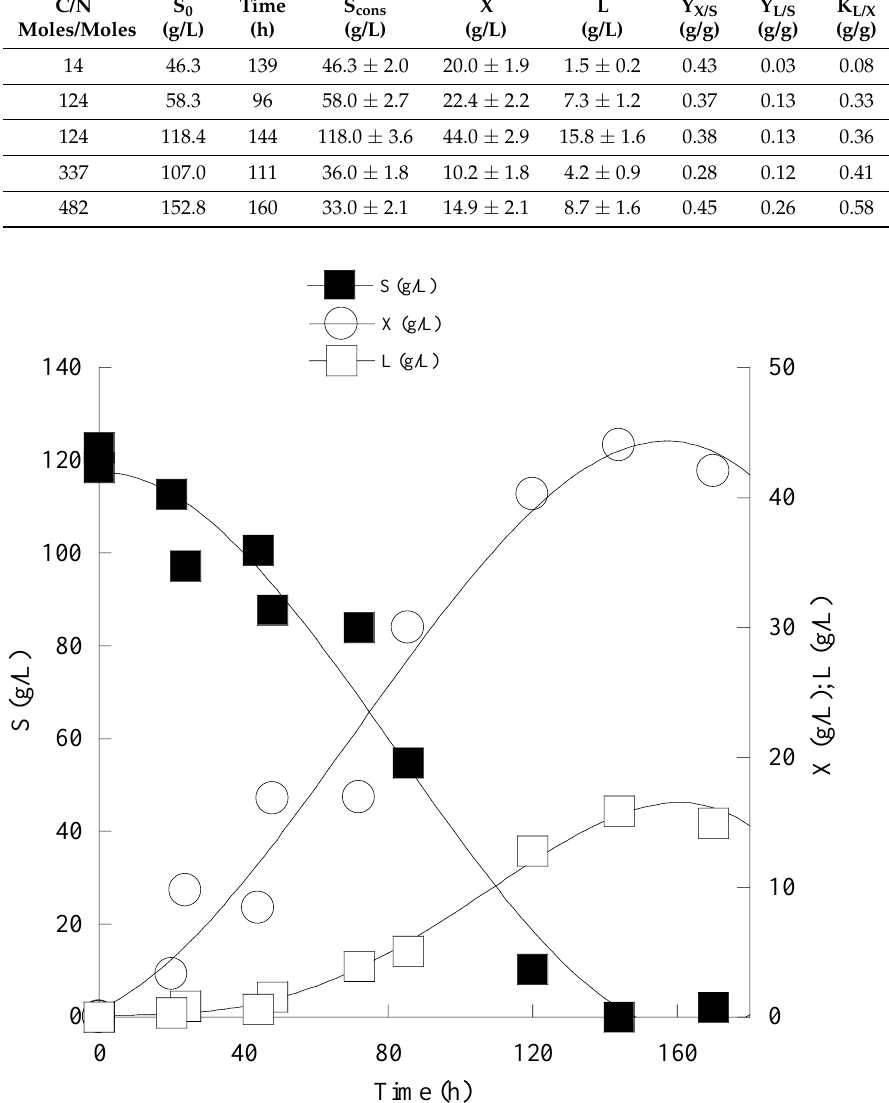
Figure 1. Kinetics of Cryptococcus curvatus ATCC 20509 batch cultivation in semi-defined medium, with lactose as carbon source (S 0 ≈ 118 g/L) and an initial C/N ratio ≈124 moles/moles.